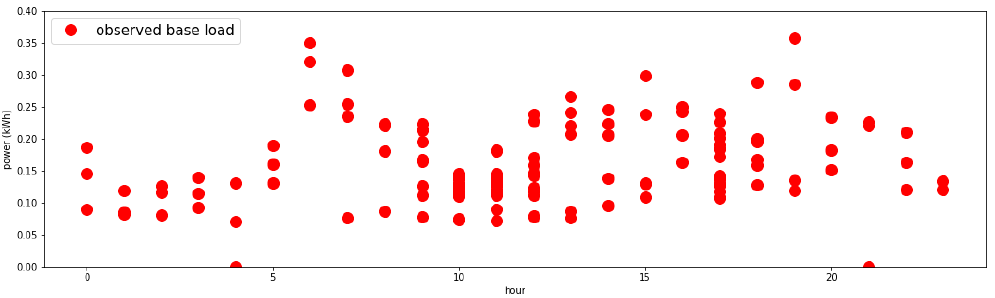
Figure 5. Sample user’s base load by time (raw data).